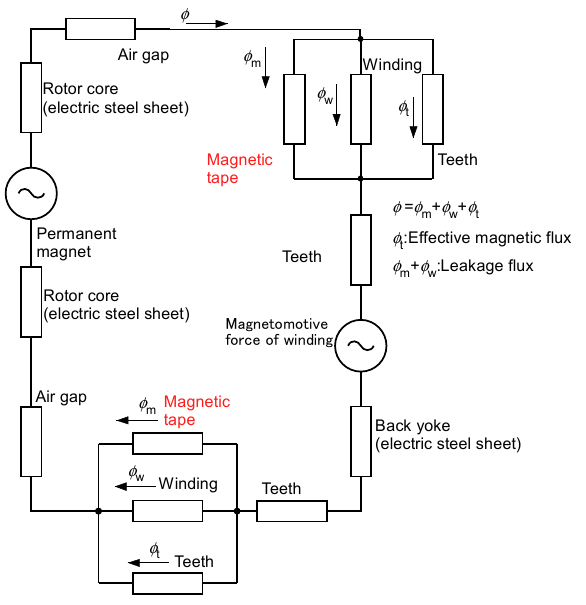
Figure 4. Magnetic circuit of the drone motor.